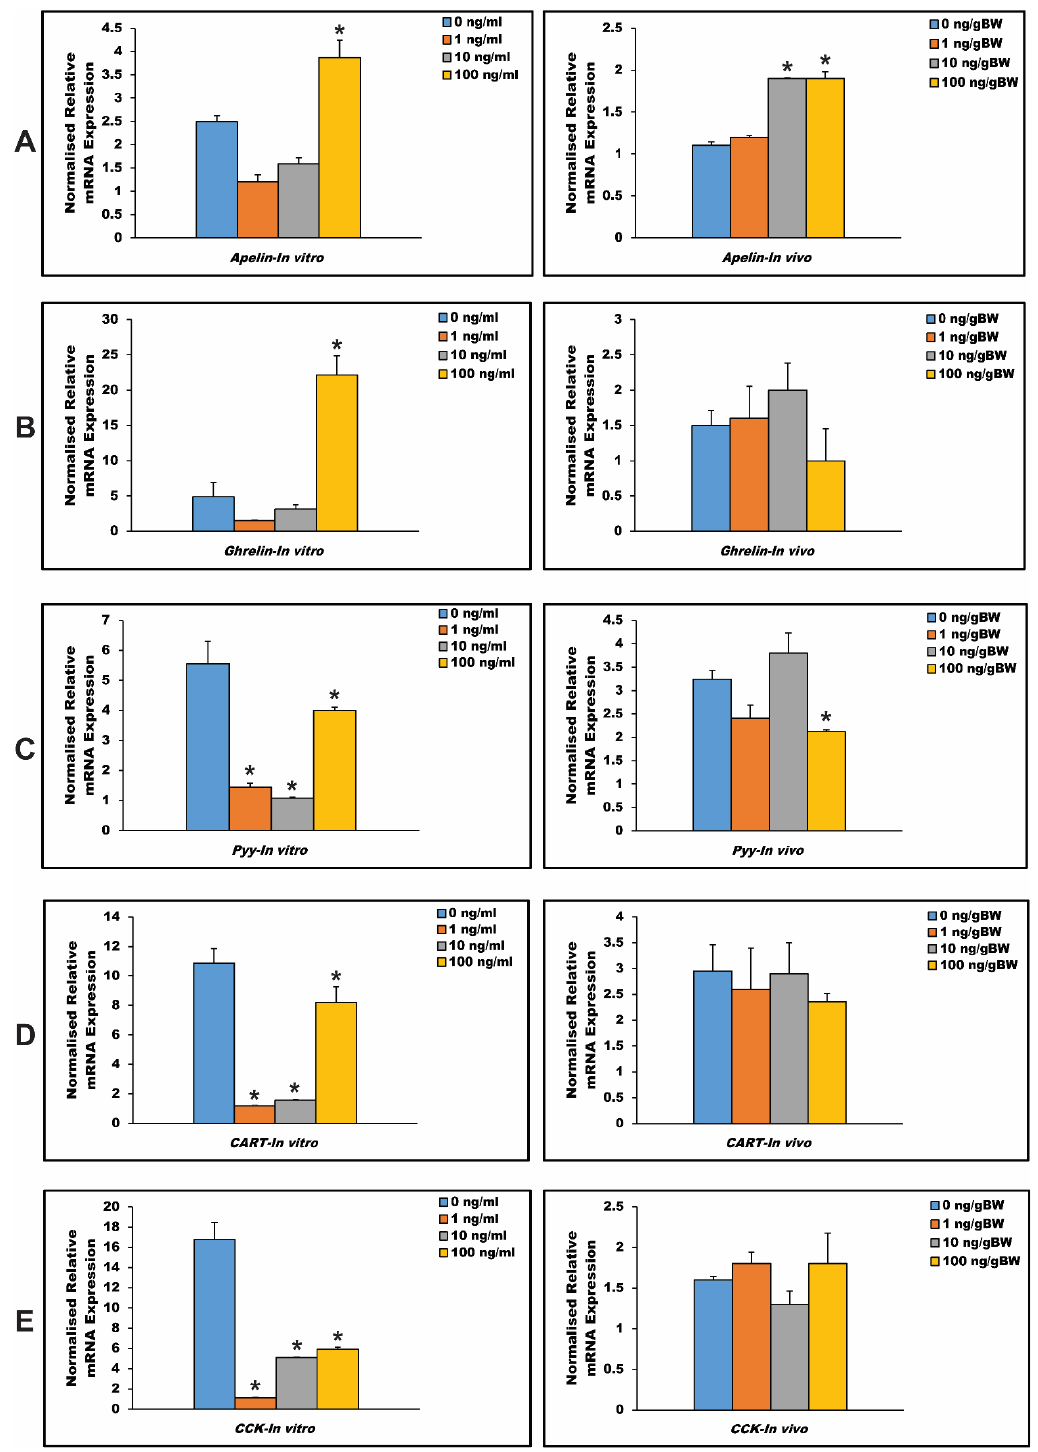
Figure 7. In vitro and in vivo effects of Npy treatment with peptide concentrations of 1